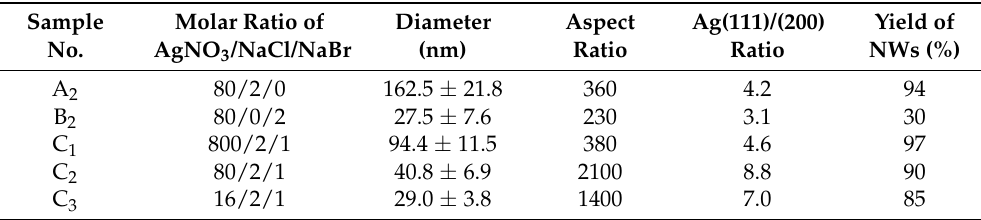
Figure 1. SEM images of AgNWs synthesized with different additives: NaCl ( a – c ), NaBr ( d – f ) and NaCl/NaBr ( g – i ) at three stages of 10 (left), 30 (middle) and 60 min (right column) in the polyol process. AgNPs were formed on the surface of AgCl crystals but inside the AgBr crystals, as indicated by arrows in ( a , d ), respectively. A fresh NW emanating from the AgCl surface was observed in ( a ), as marked by the dotted circle. The scale bar is 500 nm. Table 1. Parameters of the AgNWs obtained with different additives of NaCl (A 2 ), NaBr (B 2 ) and NaCl/NaBr (C 1 , C 2 , C 3